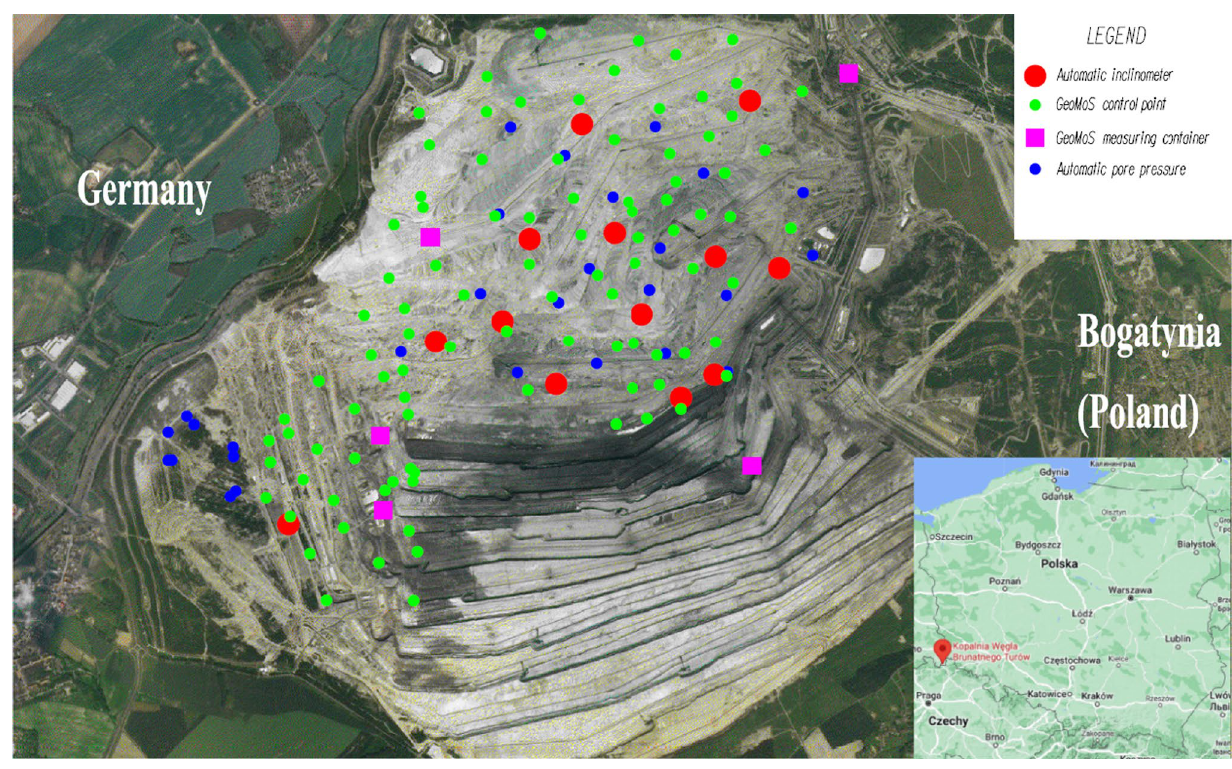
Fig. 2 Location of automatic measurement stations (from Google Maps)